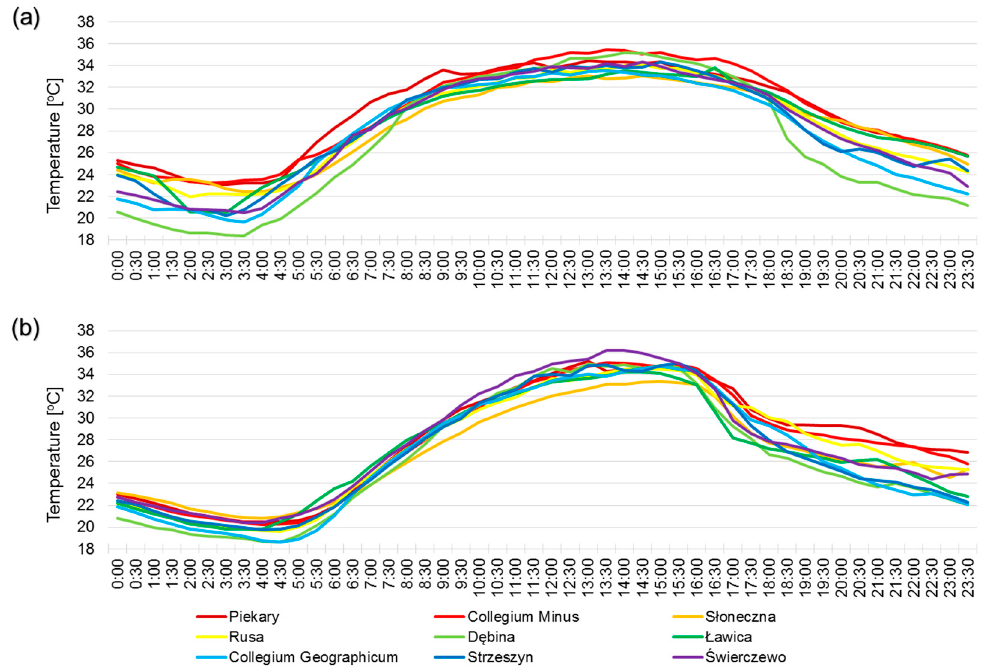
Figure 6. Daily course of air temperature in Pozna ń on 12 July 2010 ( a ) and 11 August 2015 ( b ).